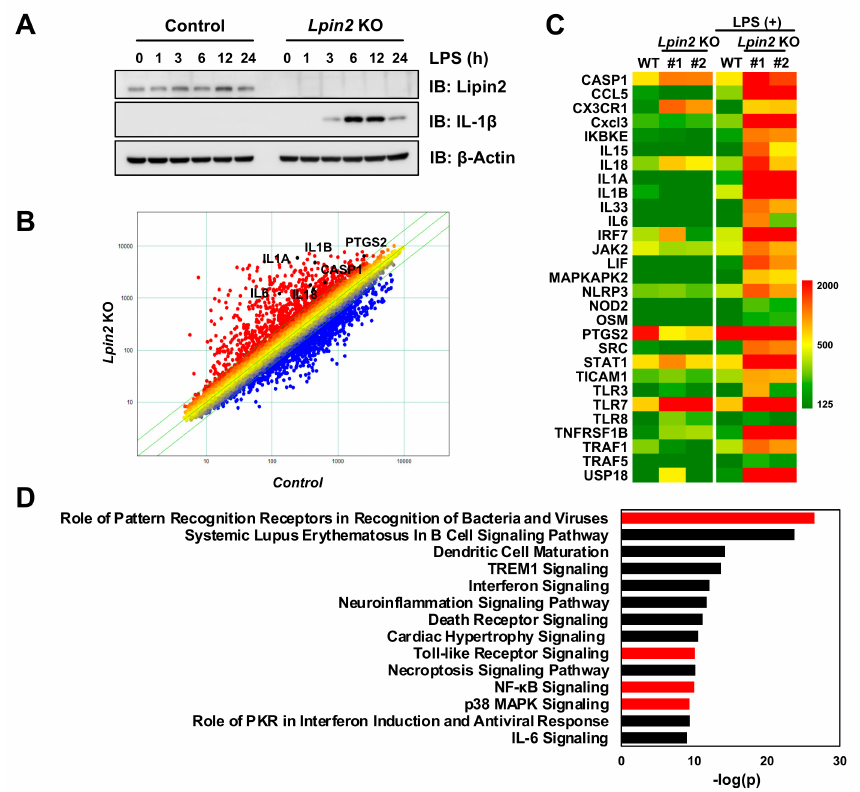
Figure 1. Lpin2 knockout elicits proinflammatory gene signature in RAW-D macrophages. ( A ) Immunoblot (IB) analysis of whole-cell lysates (WCLs) derived from control and Lpin2 knockout (KO) RAW-D cells treated with 200 ng/mL lipopolysaccharide (LPS). The cells were harvested for the IB analysis at the indicated time points. Wild-type (WT) cells were used as control. ( B ) Scatterplot comparing gene expression profiles of control (WT) (x-axis) and Lpin2 KO (y-axis) RAW-D cells treated with 200 ng/mL LPS for 4 h (red, upregulation; blue, downregulation; fold change > 2.0). ( C ) Heatmap of transcription levels of selected inflammation-related genes in control and Lpin2 KO RAW-D cells (clone #1 and #2) treated with 200 ng/mL LPS for 4 h. ( D ) “Canonical Pathways” analyzed by Qiagen ingenuity pathway analysis software for differentially expressed genes (DEGs) in Lpin2 KO RAW-D cells (fold change > 2.0) treated with 200 ng/mL LPS for 4